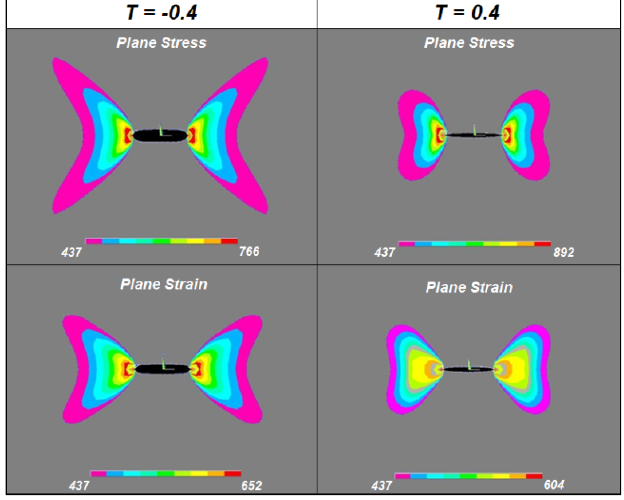
Figura 2: Variabilità di σ yy (MPa) in stato di tensione piana e deformazione piana a parità di T